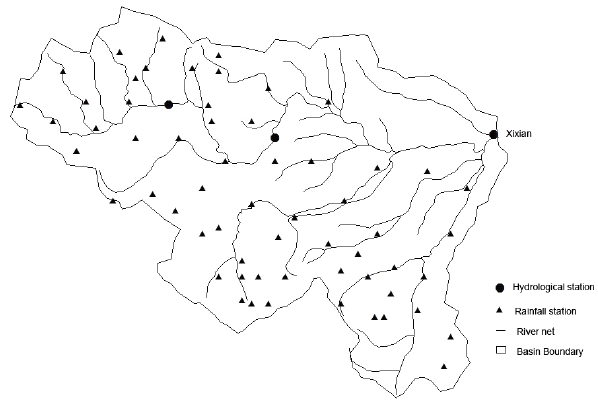
Figure 1. Sketch map of the upper Huaihe River basin.